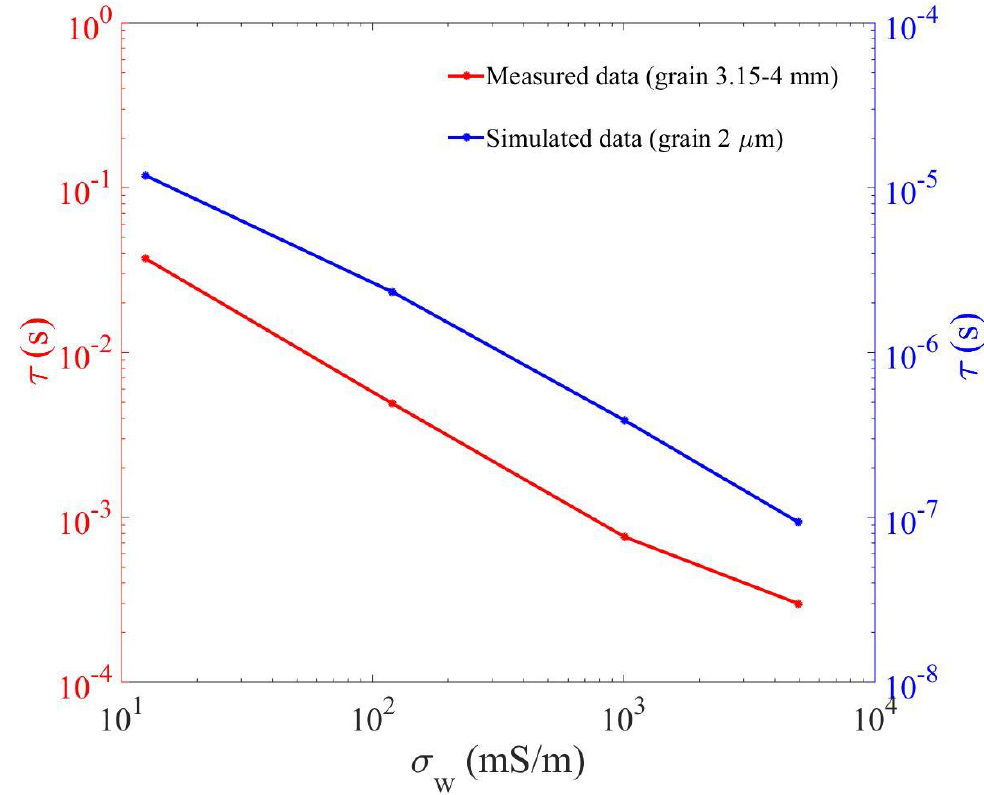
Figure 11. Dependence of the relaxation time on the conductivity of the background σ b = σ w where σ w denotes the conductivity of the KCl electrolyte that is used as the background in the numerical simulations. The vertical shift between the τ measured and the τ simulated corresponds to the distinct grain sizes in the physical and numerical experiments. These experiments show that the relaxation time is inversely proportional to the conductivity of the background.